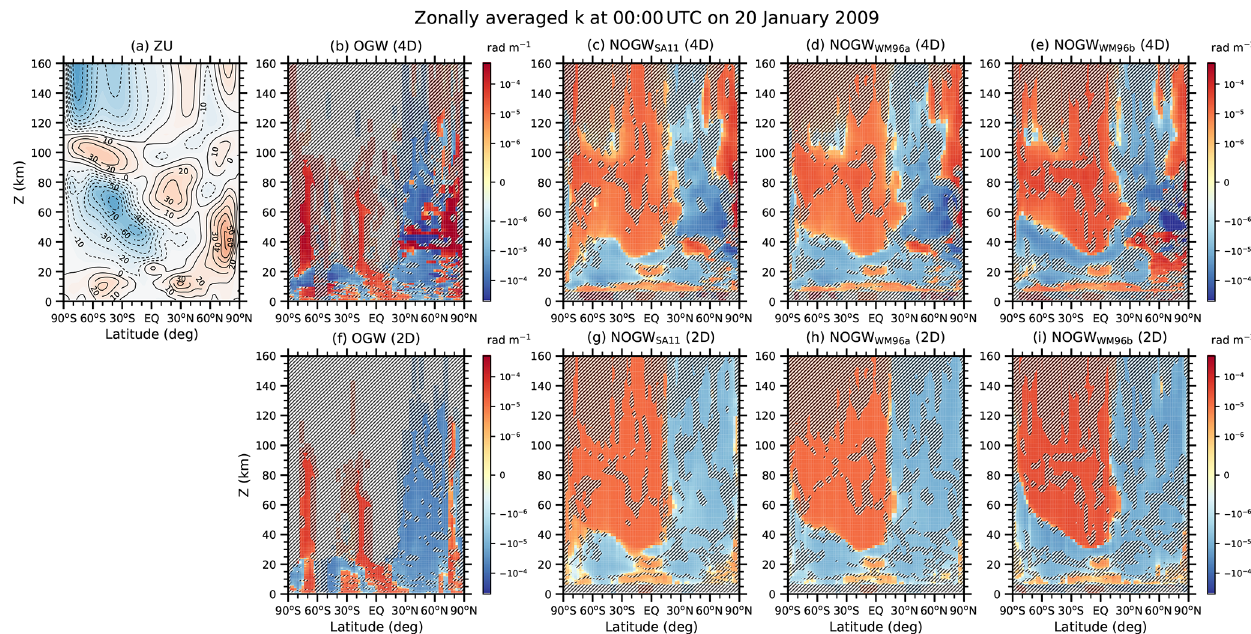
Figure 5. Latitude–height cross sections of (a) zonal mean zonal wind (ZU) and (b–i) zonal mean zonal wave numbers ( k ) for OGW and three NOGW schemes in the 4D and 2D experiments at 00:00UTC on 20 January 2009. Contour interval of zonal mean zonal wind is 10ms − 1 and negative values are plotted in broken lines. Hatched areas on the zonal wave numbers indicate regions where the paired and two-tailed t test for the 4D and 2D experiments gives p values larger than 0.05 (i.e., no statistical significance at the level of 0.05).